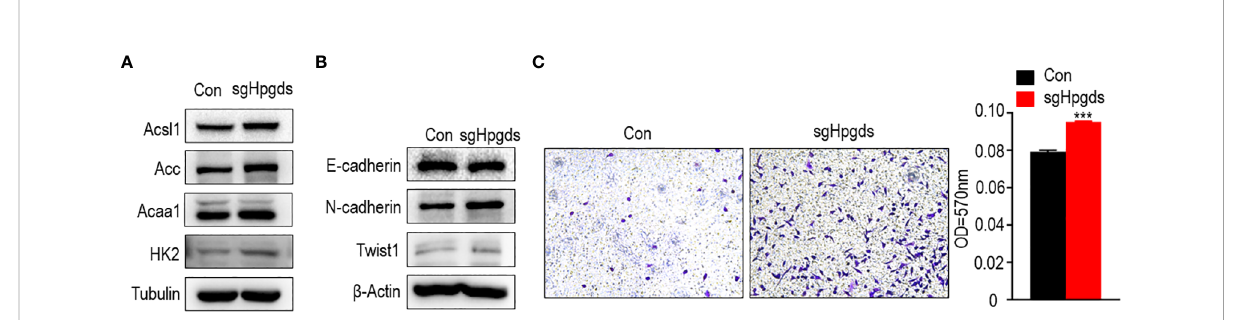
FIGURE 6 (A) Western blotting of the expression of lipid metabolism-related markers in normal control A549 cell line (NC) and HPGDS knockout A549 (sgHPGDS) group. (B) Knockdown of HPGDS promotes the EMT related markers of A549. (C) Knockdown of HPGDS enhances the migration of A549 cells. ***P<0.001.